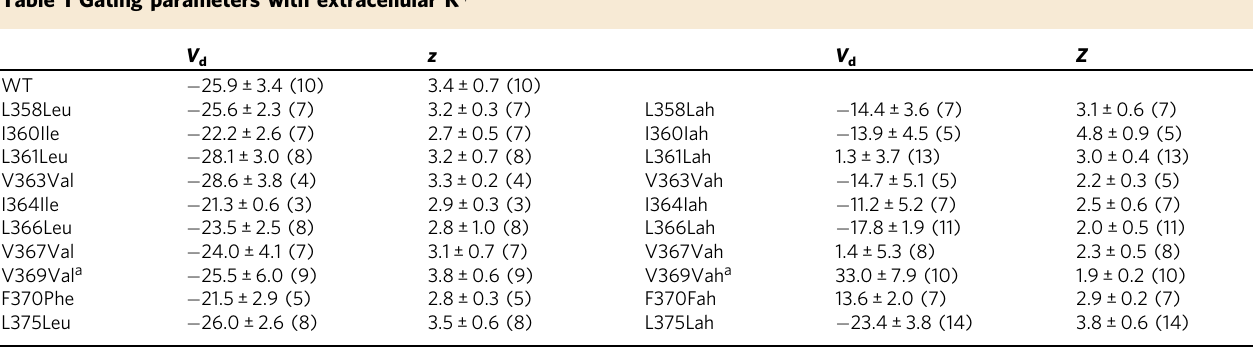
Table 1 Gating parameters with extracellular K +